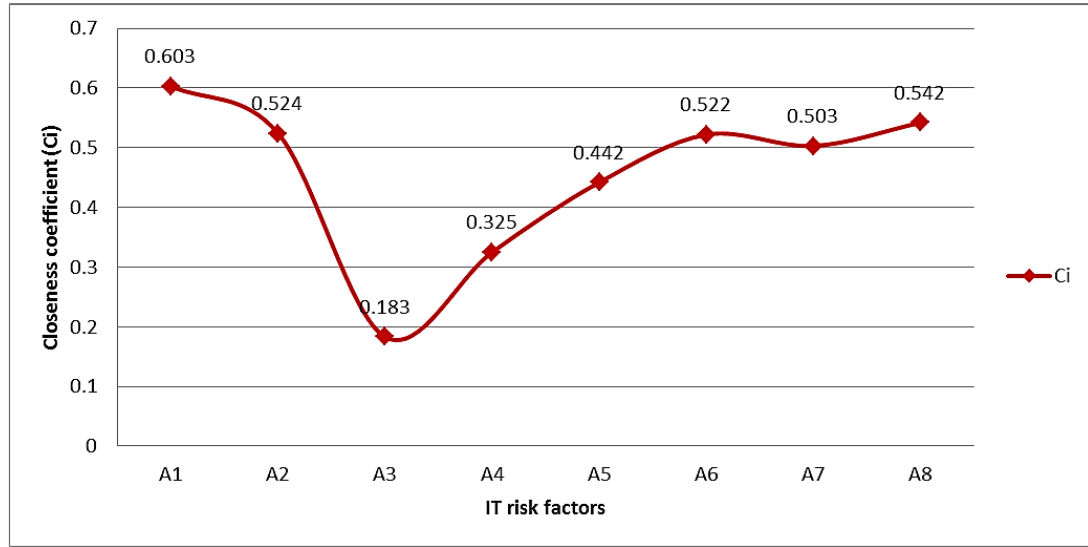
Figure 5. Closeness coefficient